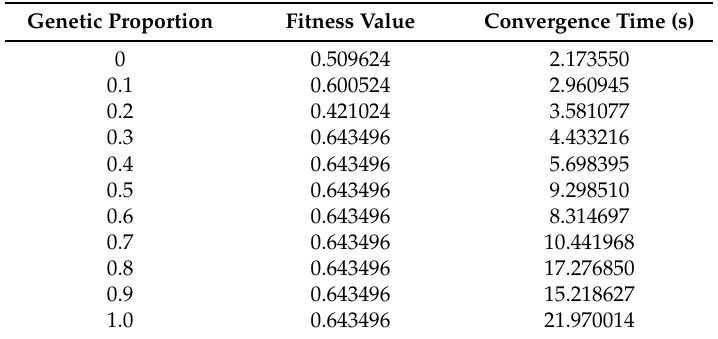
Table 3. Fitness value and the corresponding convergence time at different P g .